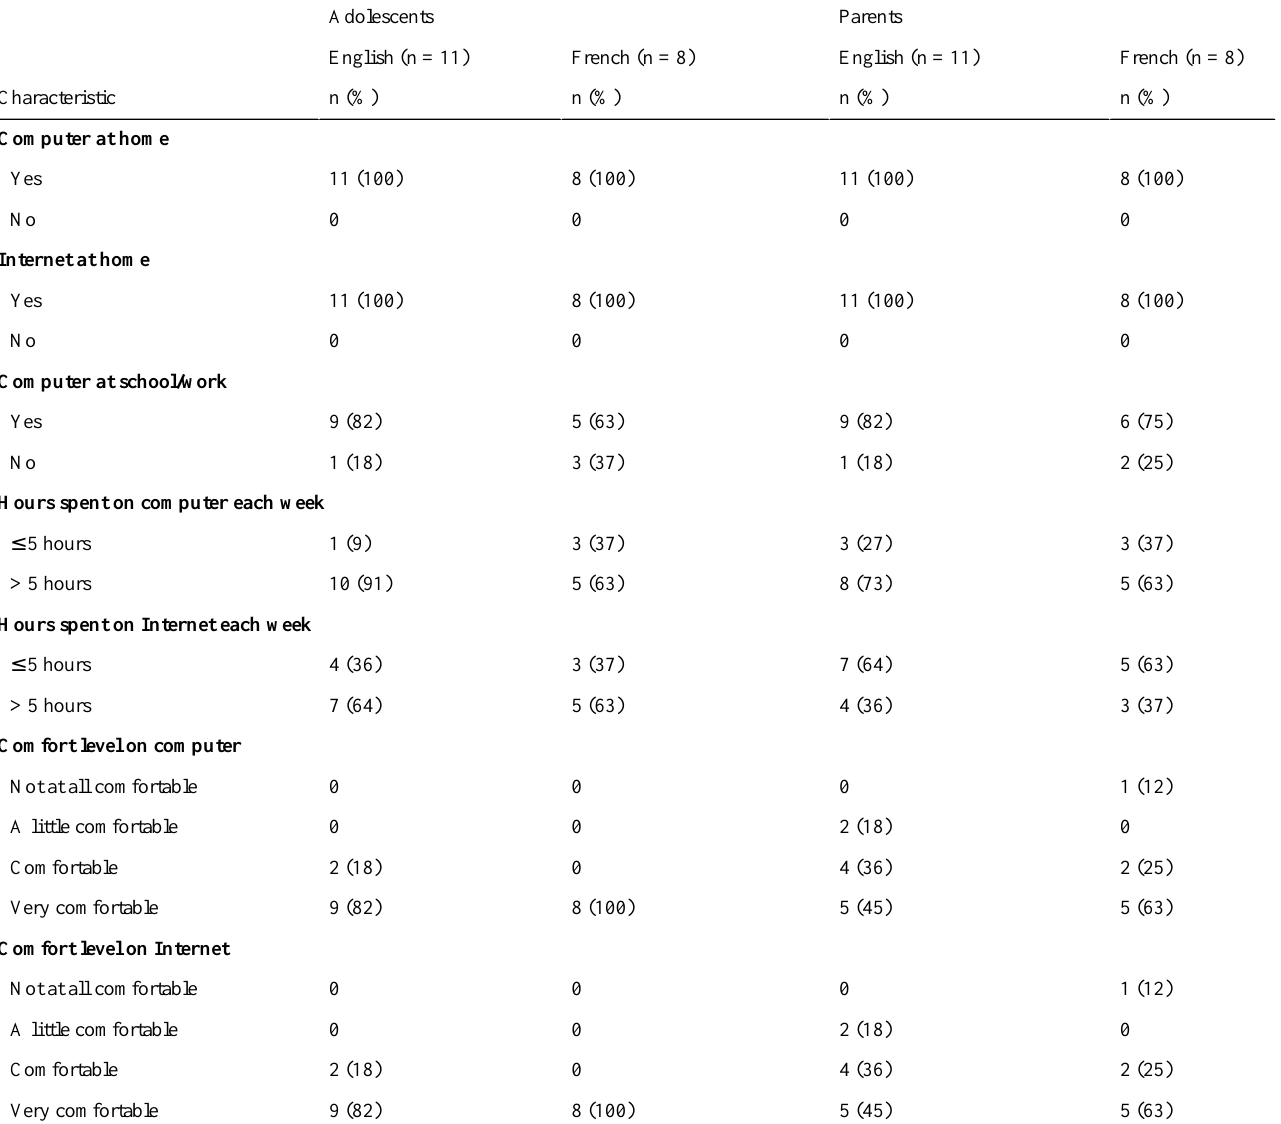
Table 2. Information about use of the computer by adolescents and their parents